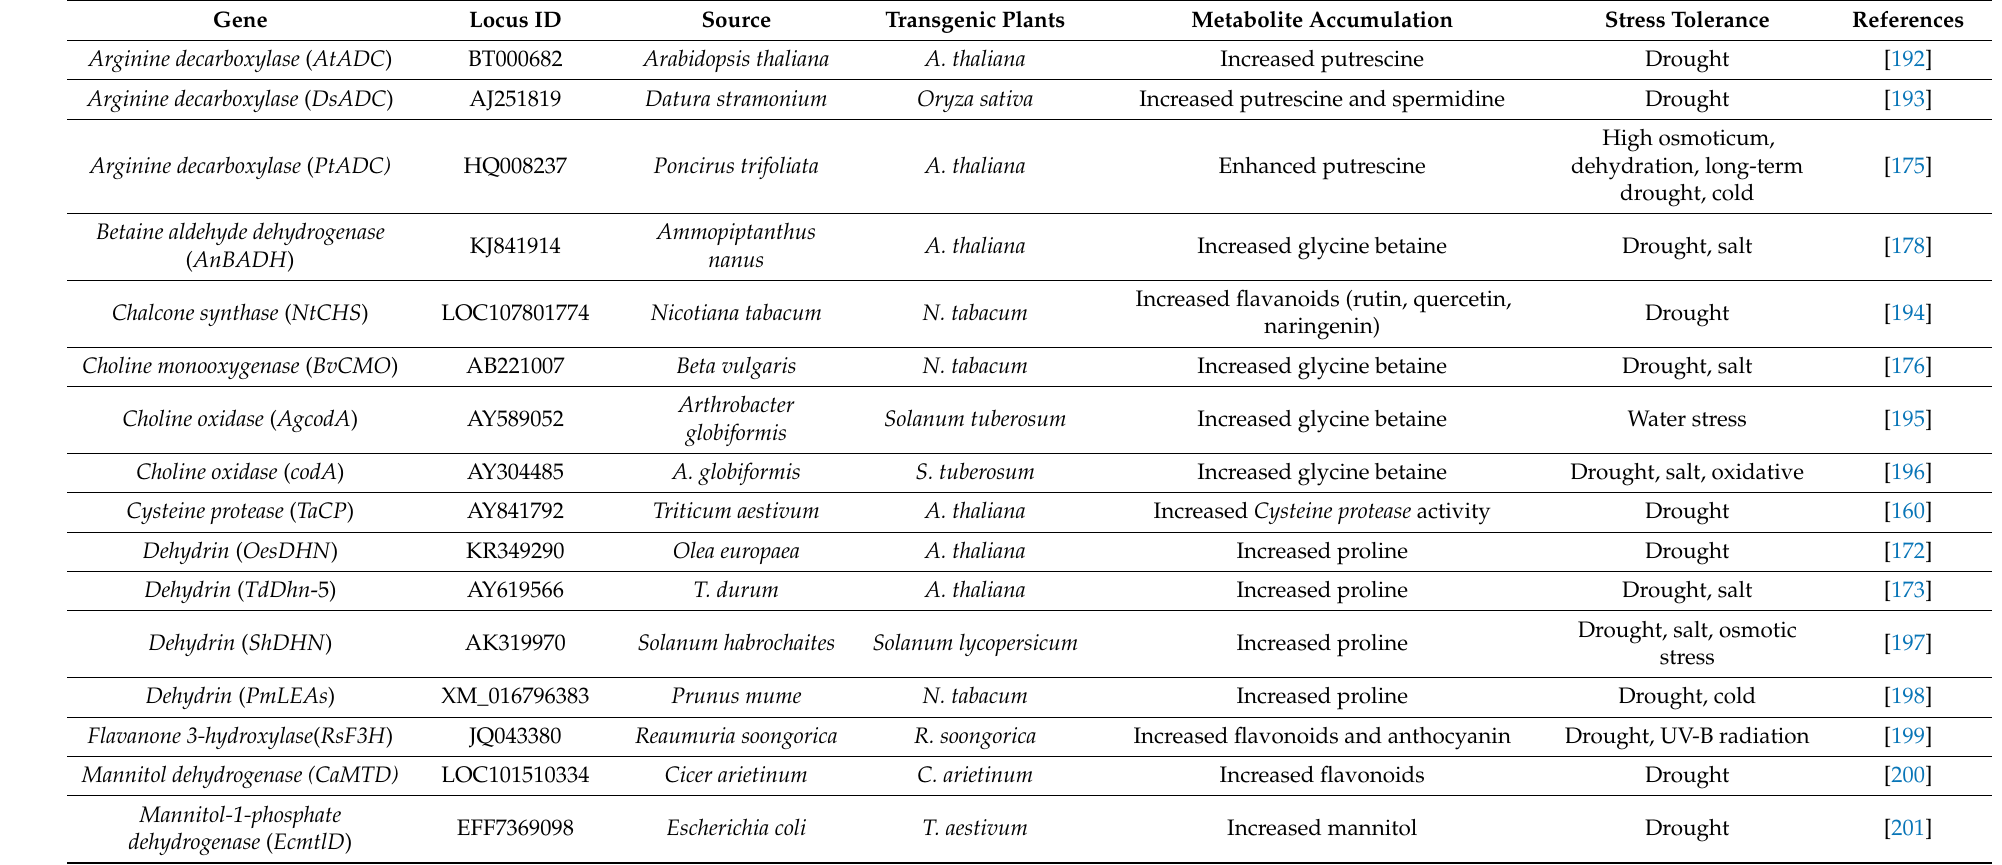
Table 2. Application of metabolic genes for generating transgenic crops with improved drought